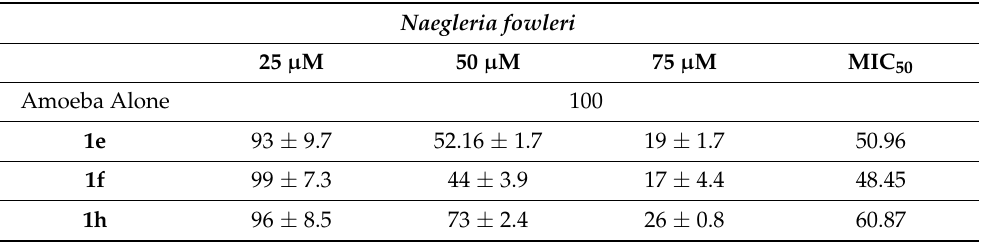
Table 1. The MIC 50 values of the compounds against N. fowleri were determined for the various compounds against N. fowleri . Concentrations of 25 µM, 50 µM, and 75 µM were tested.